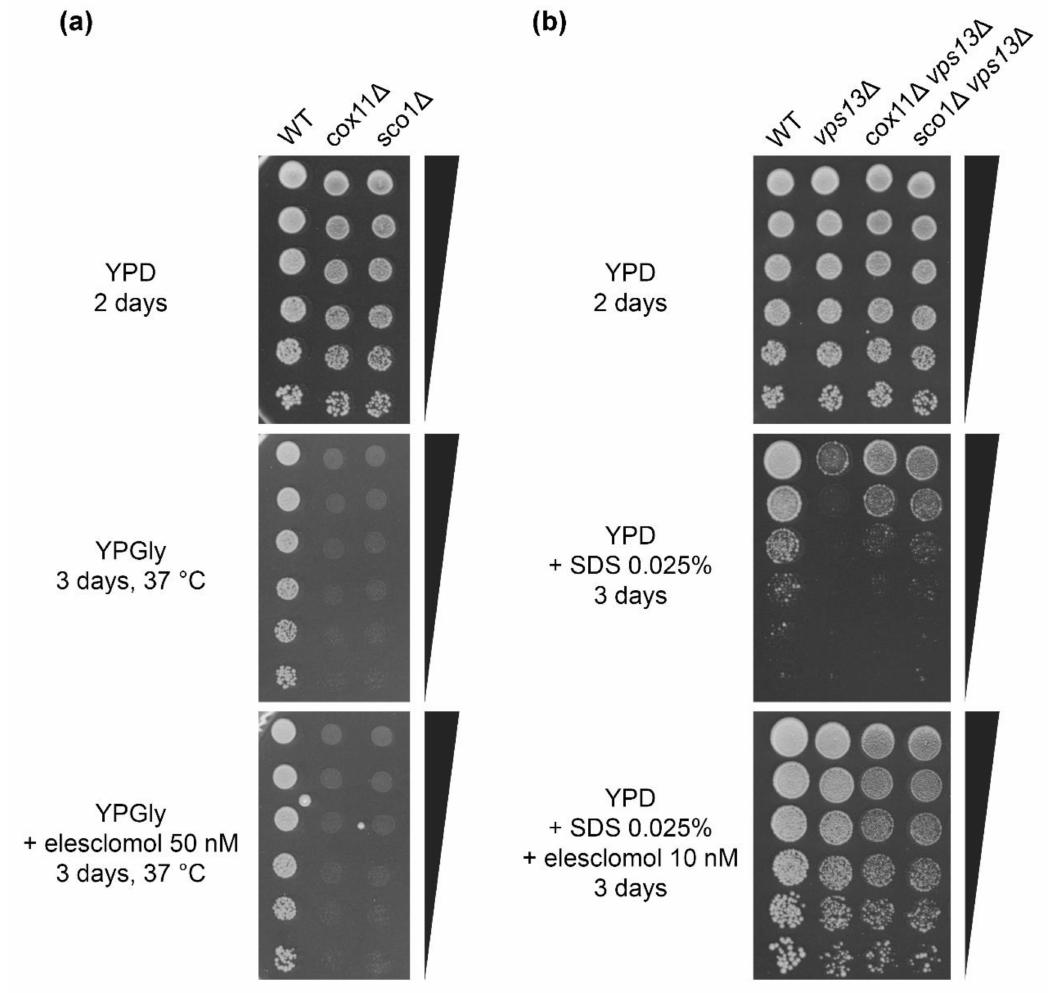
Figure 7. Elesclomol does not restore respiratory growth of yeast when CcO is inactivated, but CcO is not relevant for elesclomol suppression of vps13 ∆ on YPD + SDS media. ( a ) cox11 ∆ and sco1 ∆ respiratory growth defect is not restored by elesclomol. Growth of wild type, cox11 ∆ and sco1 ∆ strains was compared by a drop test on plates with YPD and glycerol-containing YPGly and YPGly + elesclomol media in 30 ◦ C or 37 ◦ C. ( b ) COX11 and SCO1 are not required for elesclomol effect on vps13 ∆ growth on YPD + SDS media. Growth of wild type, vps13 ∆ , cox11 ∆ vps13 ∆ , and sco1 ∆ vps13 ∆ strains was compared by a drop test on plates with YPD, YPD + SDS and YPD + SDS + elesclomol